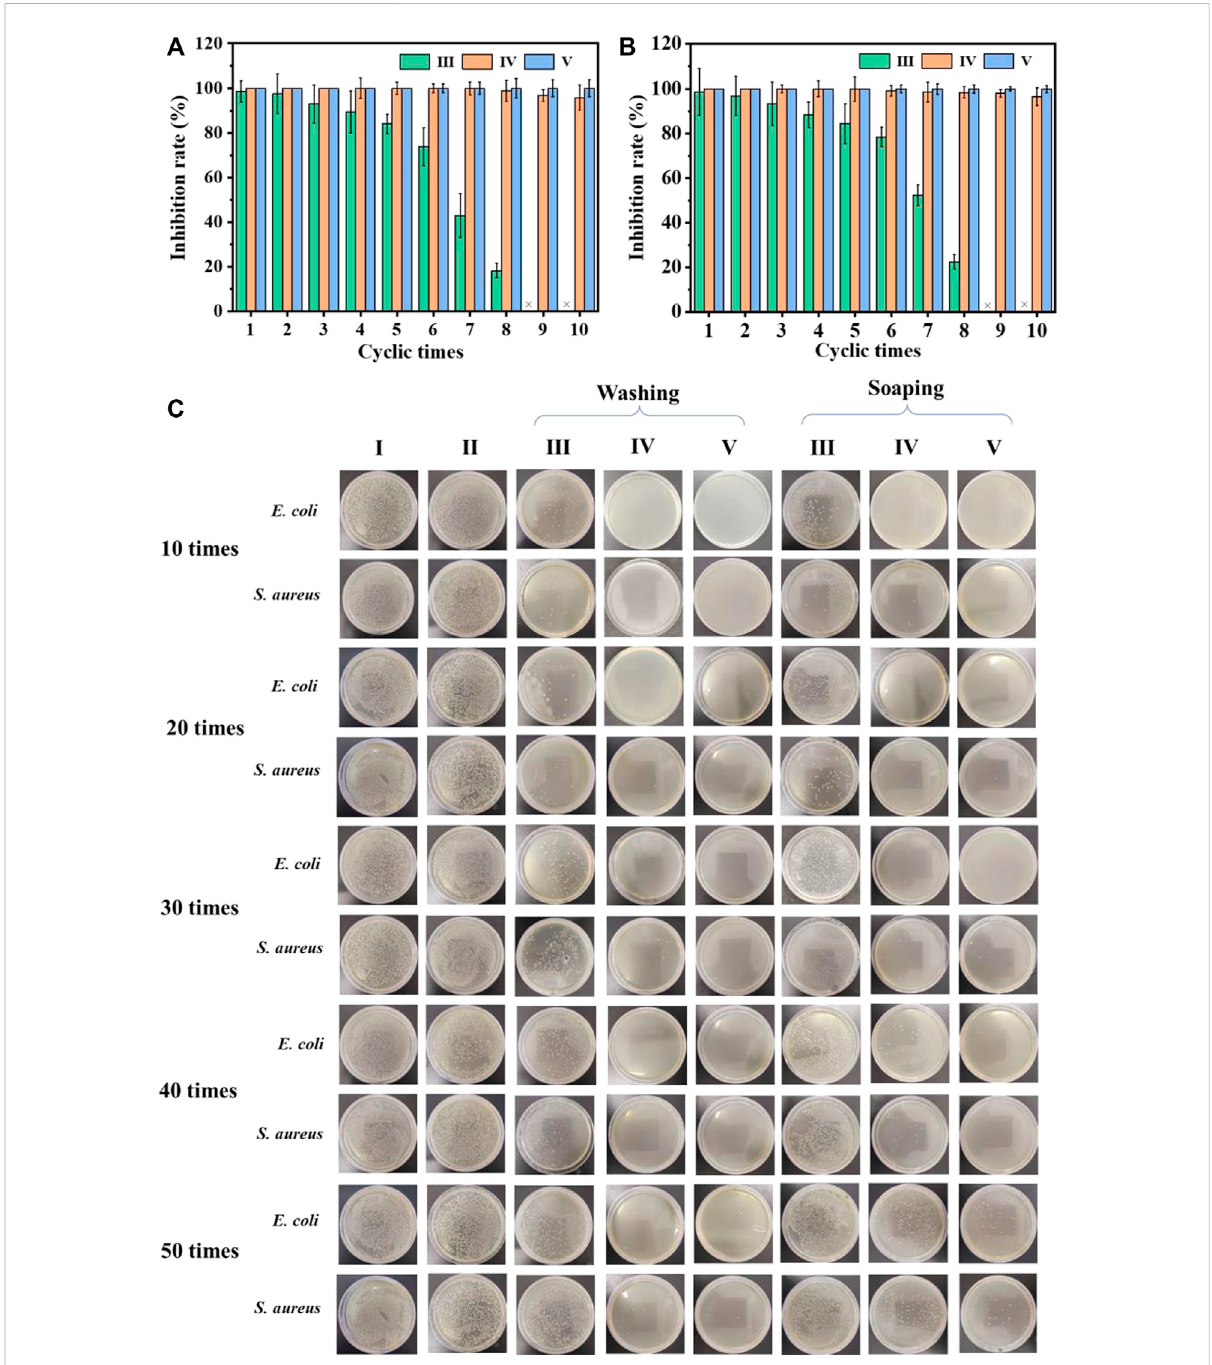
FIGURE 4 The recycling antibacterial results of the uncoated cotton fabric and coated cotton fabric against E. coli (A) and S. aureus (B) ; the bactericidal activityofthecoatedcottonfabricagainst E.coli and S.aureus afterdifferentwashingandsoapingcycles (C)